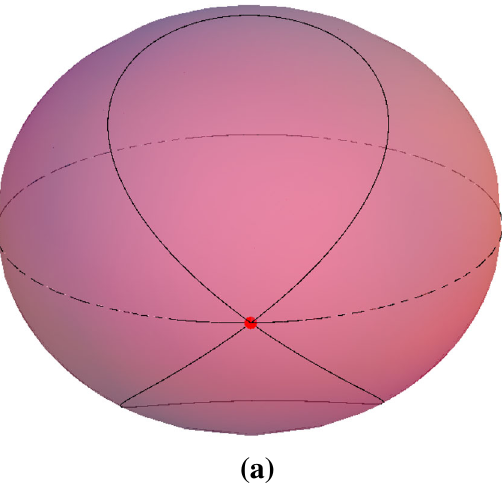
√ r = r pol + = r pol − = 3 = r pol b . Note that the latter orbit is globally retrograde (c. f. detail in Fig. 6e)